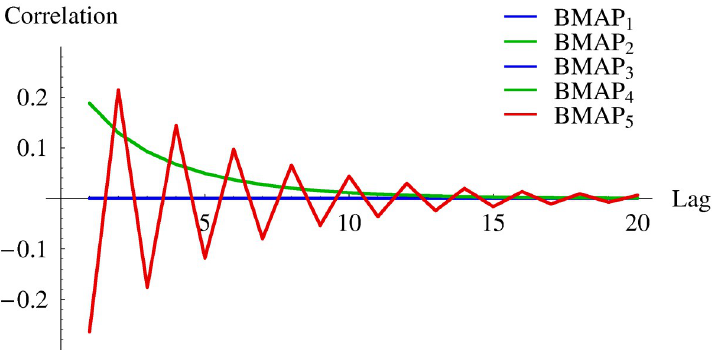
Fig 1. The autocorrelation function of interarrival